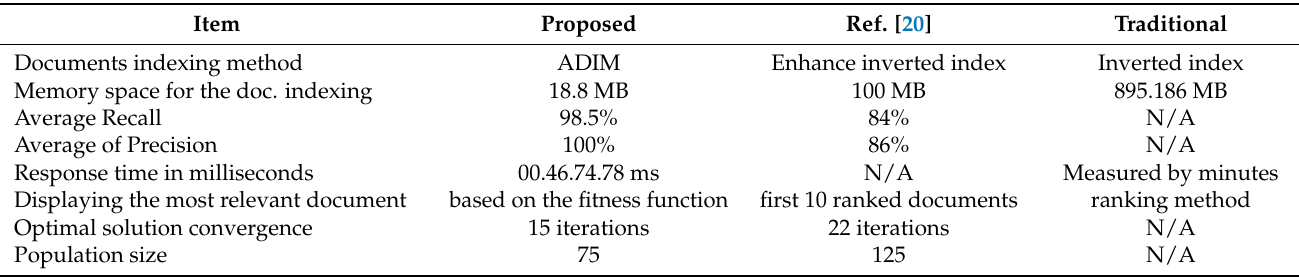
Table 11. Comparison with traditional and other related work.